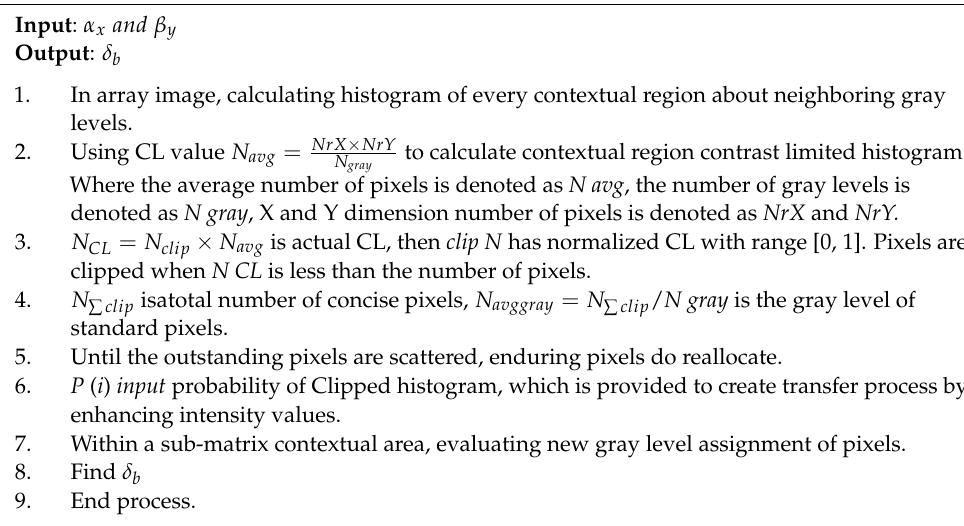
Algorithm 1 : Procedure : Using AHCN-LNQ, image features are learned and